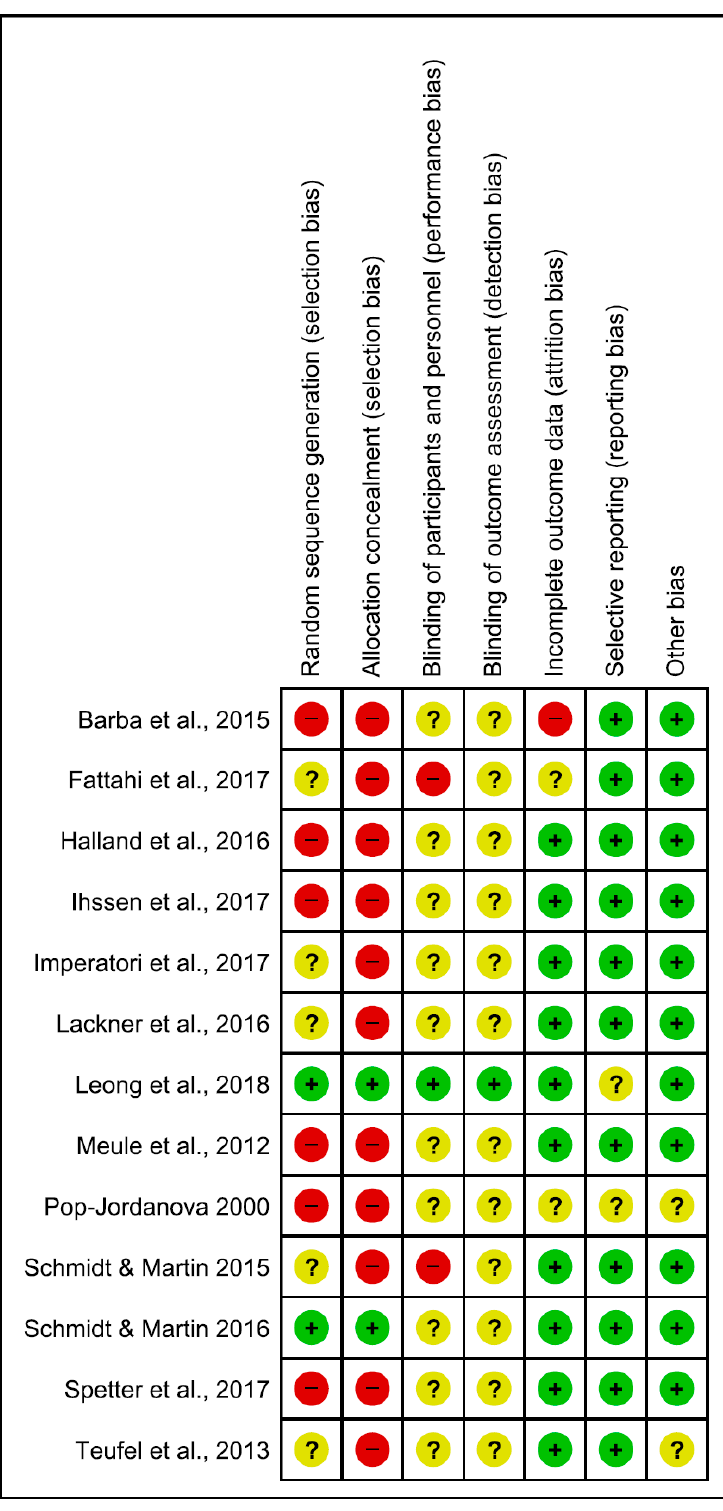
Figure 2. Risk of bias summary: review authors’ judgements about each risk of bias item for each included study. Green, yellow and red circles represent low, unclear and high risk of bias respectively.